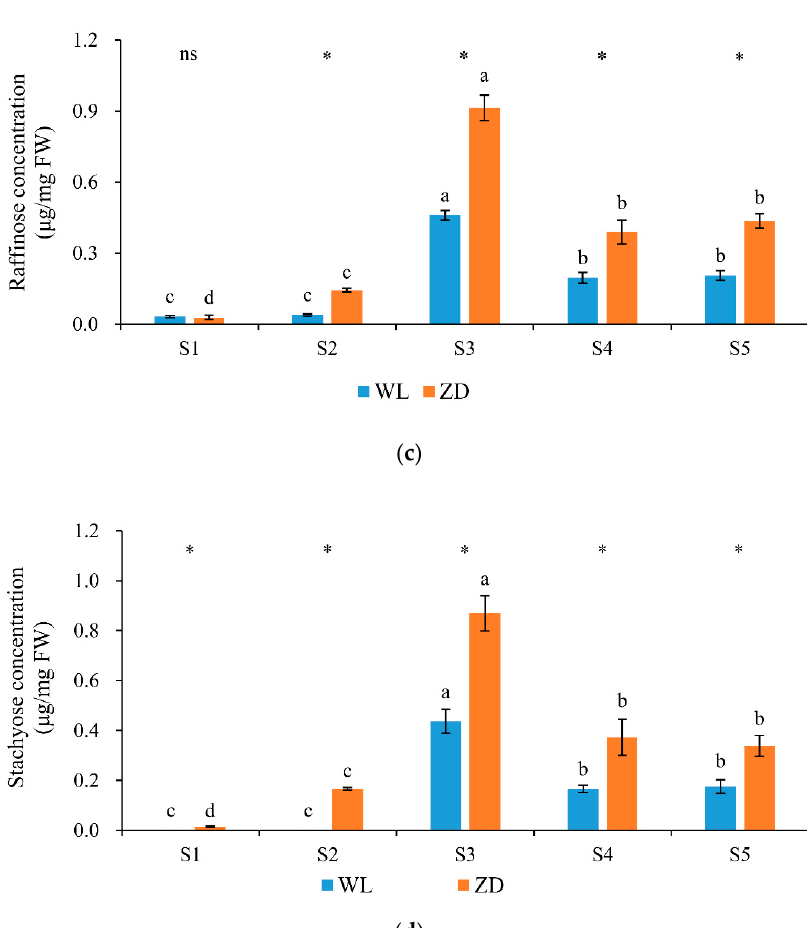
Figure 4. Soluble sugar concentrations in alfalfa crowns at five sampling points. Mean values ( n = 5) ± standard errors of the mean are shown. Different letters (a, b, etc.) above bars indicate a significant difference among the five sampling points (from S1 to S5) in one cultivar ( p < 0.05). The asterisk indicates a significant difference between the two cultivars (S1 vs. S1, S2 vs. S2, etc.) at one same sampling point ( p < 0.05), and the ‘ns’ indicates no significant difference. S1 to S5 are the sampling points after the five phases of the temperature-controlled treatment regime: in phase 1 the temperature was maintained at 18 °C, in phase 2 it decreased to 2 °C, in phase 3 it was maintained at 2 °C and − 2 °C for two weeks, in phase 4 it increased to 18 °C, and in phase 5 it decreased to 2 °C. ( a ) total soluble sugar; ( b ) sucrose; ( c ) raffinose; and ( d ) stachyose. WL = WL440HQ, ZD = ZhaoDong.